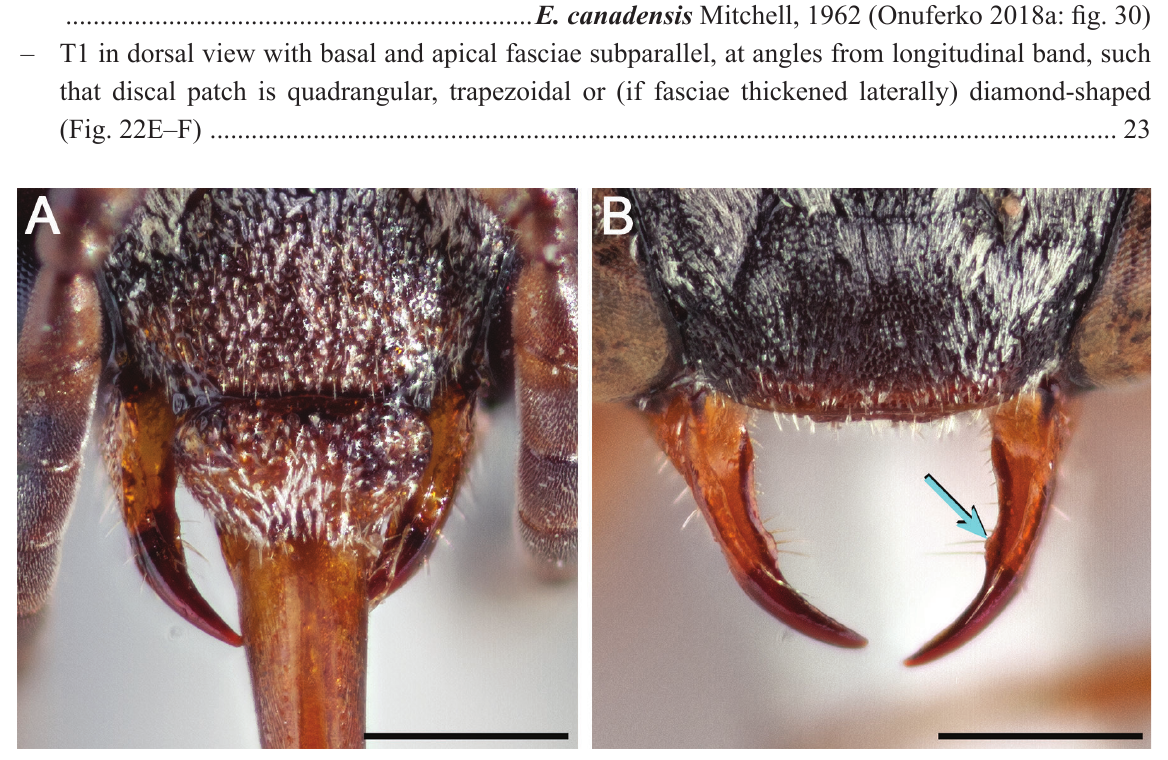
Fig. 24. Mandibles of female A . E. ainsliei Crawford, 1932, each of which lacks a preapical tooth. B . E. rufulus Cockerell, 1941, each of which has a blunt, obtuse preapical (almost submedial) tooth (blue arrow). Scale bars = 0.5